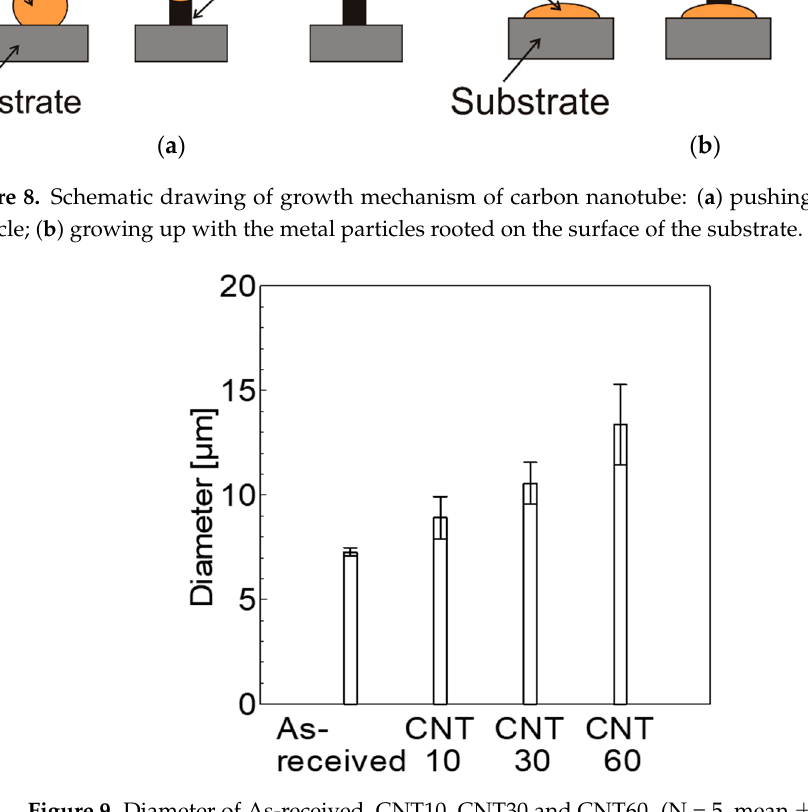
Figure 9. Diameter of As ‐ received, CNT10, CNT30 and CNT60. (N = 5, mean ± S.D.).